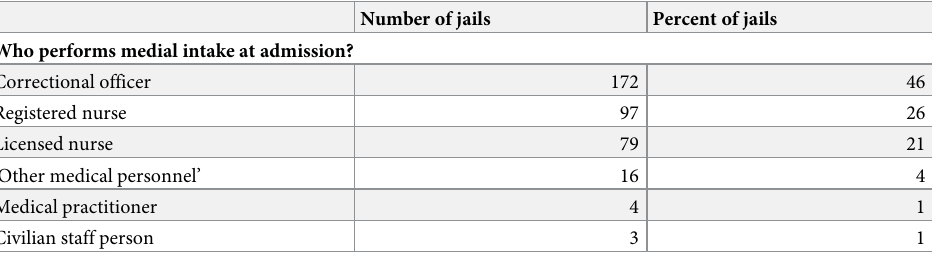
Table 2. Staffing for medical